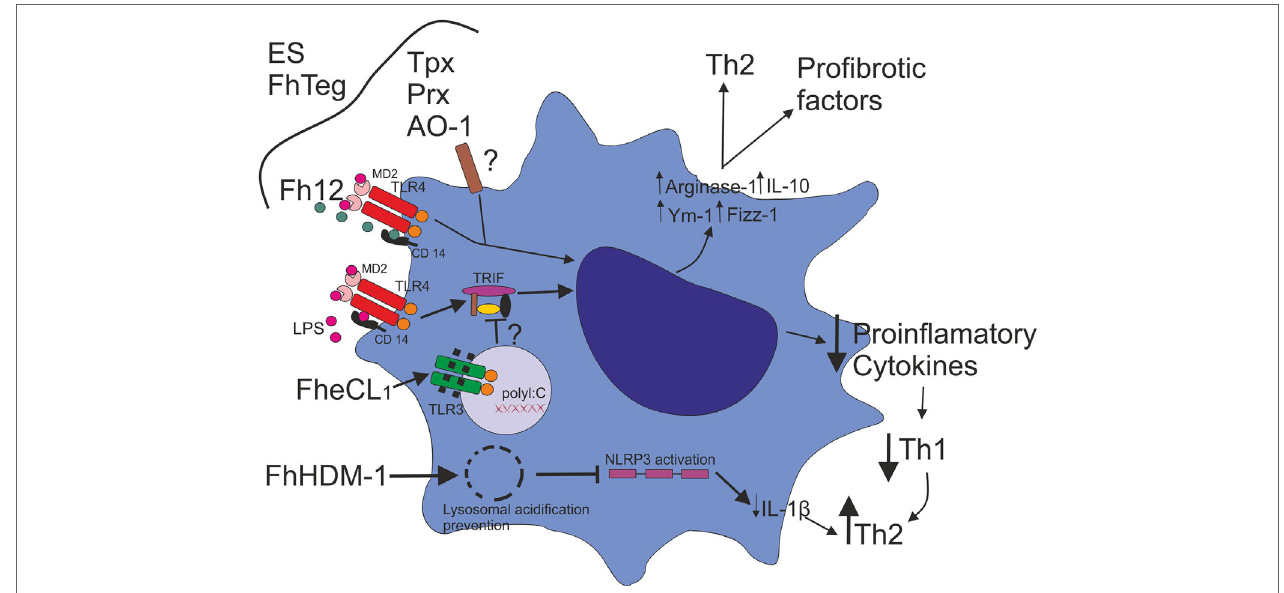
FiGURe 1 | Fasciola hepatica modulates macrophage activation . F. hepatica ES, F. hepatica tegumental antigens (FhTeg), and ES-derived enzymes, such as thioredoxin peroxidase (Tpx), 2-Cys peroxiredoxin (Prx), and heme-oxygenase-1 (AO-1) drive Mo phenotype toward an alternative activation profile. Fatty acid binding protein (Fh12) binds the co-receptor CD14 and inhibits LPS-induced TLR4 activation, suppressing the expression of IL-12, TNF, IL-6, and IL-1 β . F. hepatica Cathepsin L1 (FheCL1) induces TLR3 degradation, which impairs LPS-induced TLR4–TRIF-dependent pathway with the consequent inhibition of inflammatory cytokine production. The decrease of an inflammatory cytokine milieu might promote the inhibition of a Th1 type response favoring a Th2 profile. F. hepatica defense molecule 1 (FhHDM-1) has been shown to have the ability to destabilize lysosomal acidification, which impairs Mo NLRP3 activation and consequently inflammasome function, resulting in the downregulation of IL-1 β